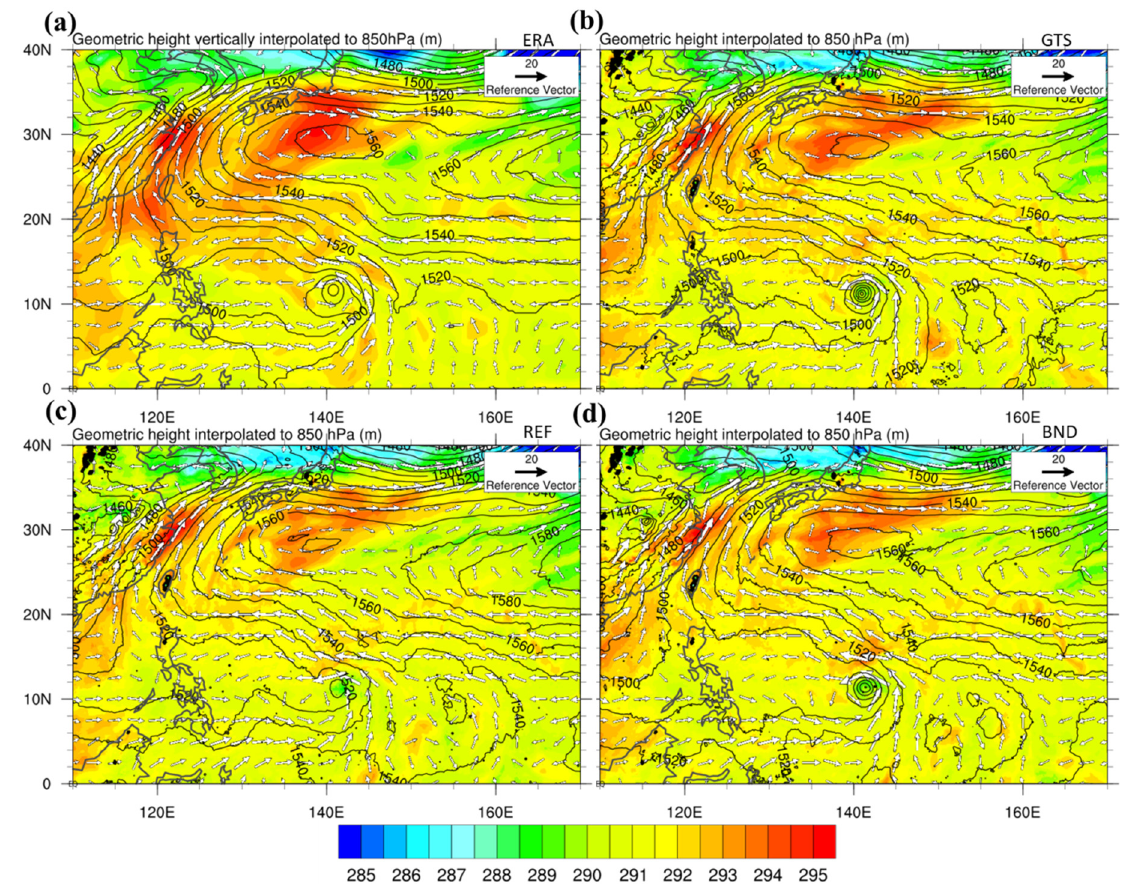
Figure 5. Geometric height (contours at an interval of 10 m), temperature (shaded in K), and wind vector (m s − 1 ) at 850 hPa at 0000 UTC 04 July 2016 (the end assimilation) for ( a ) the ERA-Interim, ( b ) GTS, ( c ) REF, and ( d ) BND.